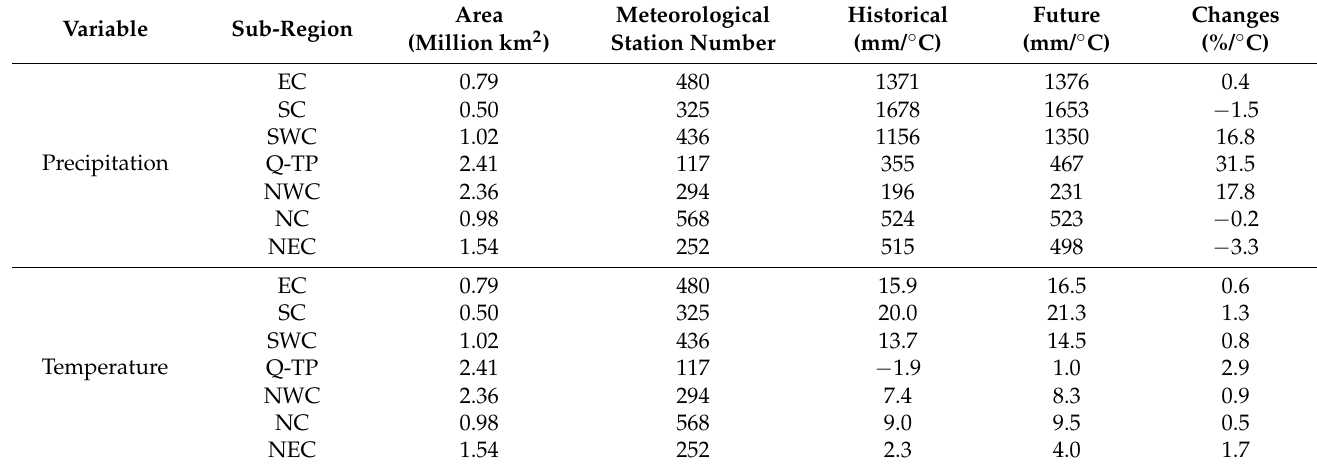
Table 1. The average annual precipitation (mm) and temperature ( ◦ C) during the historical (1961–2020) and the future (2021–2100) periods for each sub-region, together with the information of the area (million km 2 ) and meteorological station